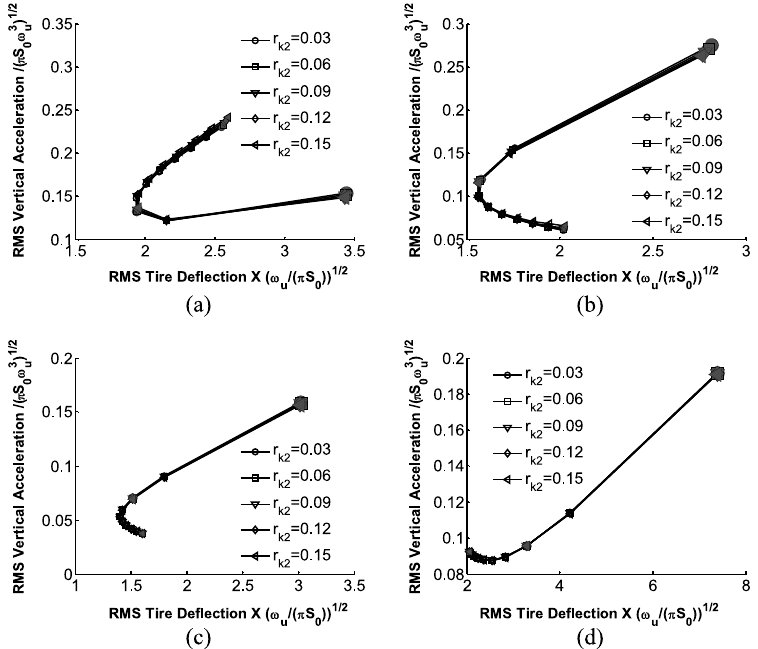
Fig. 11. Relationship between RMS acceleration and RMS tire de fl ection with layout s8 (effect of centering spring k 2 and damping): (a) Passive; (b) Groundhook; (c) Hybrid; (d)